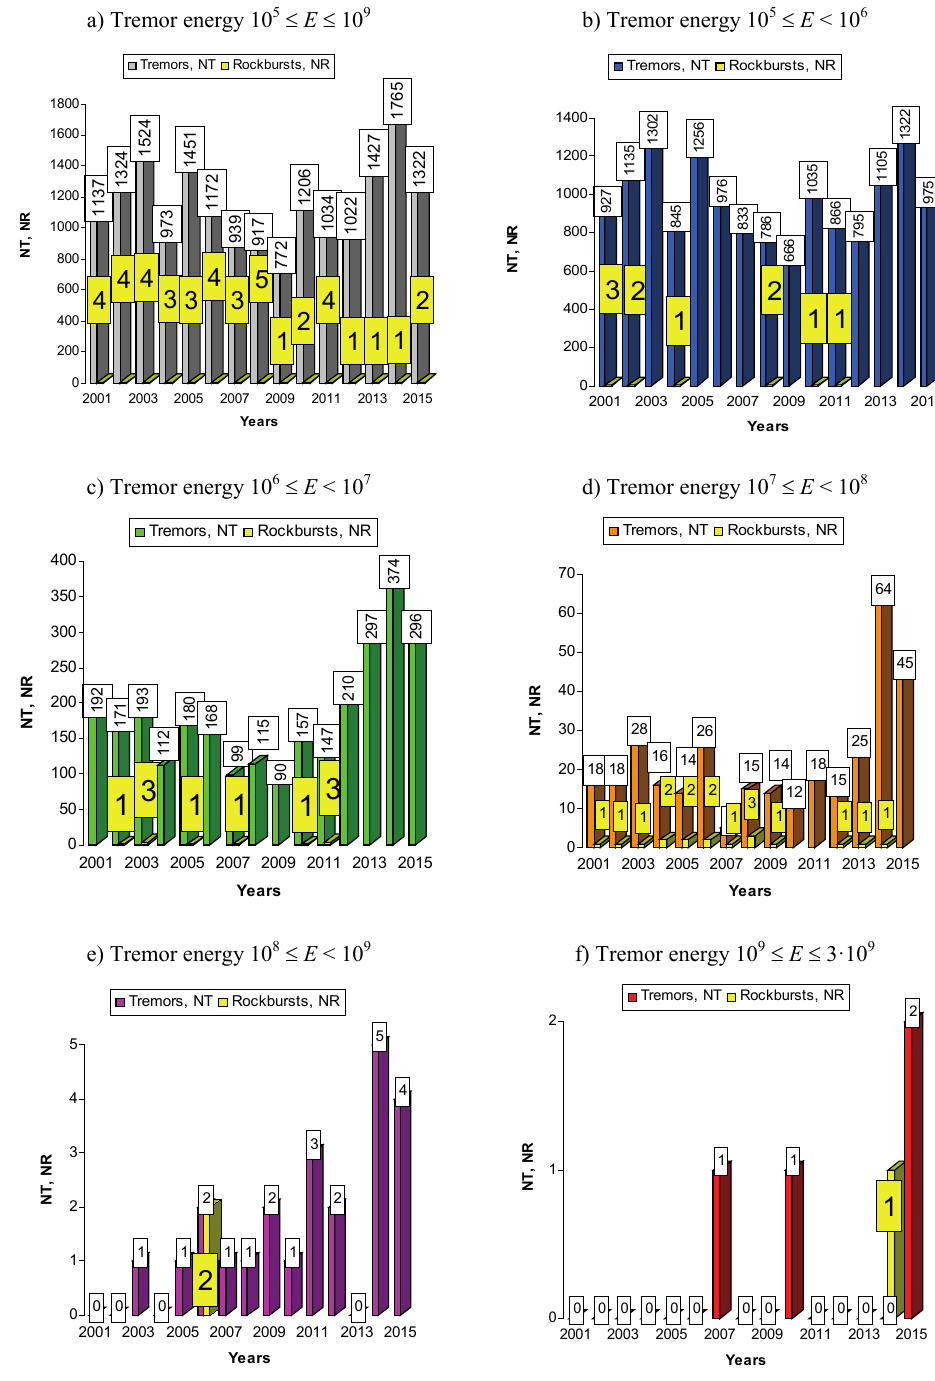
Fig. 4. Quantitative and energetic distribution of rock mass tremors in the Upper Silesian Coal Basin between 2001 and 2015; NT – number of tremors, NR – number of